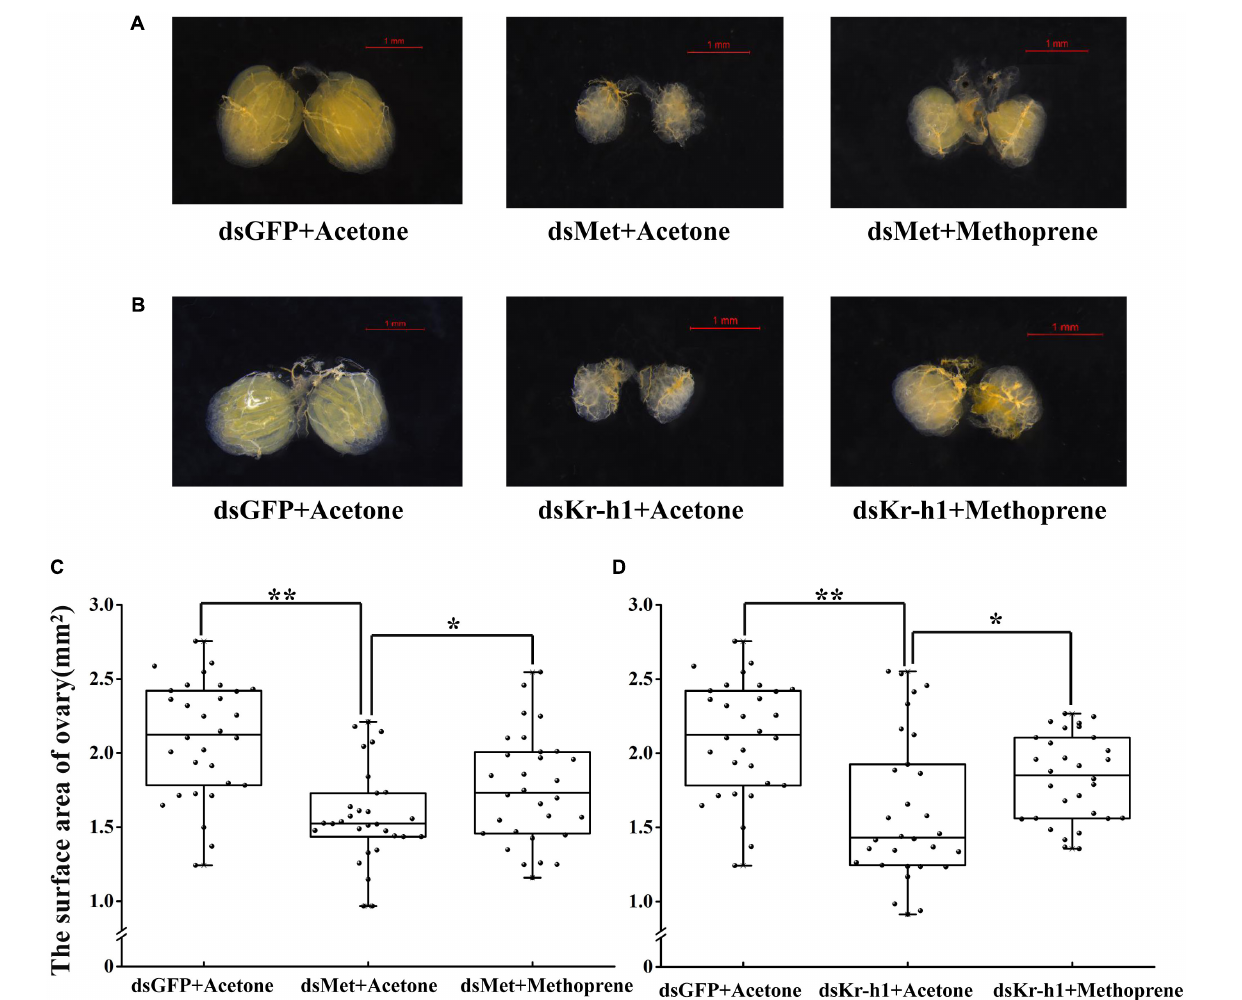
FIGURE 7 | Effects of methoprene treatment on ovary in Met- and Kr-h1- depleted female adults. Ovary phenotypes of 7-day-old adults were observed and recorded. Methoprene was applied 2 h after dsRNA injection on 4-day-old female adults. Rescue with methoprene after dsMet injection (A) with two controls (i.e., dsGFP + Acetone and dsMet + Acetone) and dsKr-h1 injection (B) with two controls (i.e., dsGFP + Acetone and dsKr-h1 + Acetone). The surface area of ovary recorded after rescue with methoprene after Met RNAi (C) and Kr-h1 RNAi (D) . Every dot means the surface area of individual ovary. The asterisks indicate statistically significant difference between measurements ( ∗ P < 0.05; ∗∗ P <